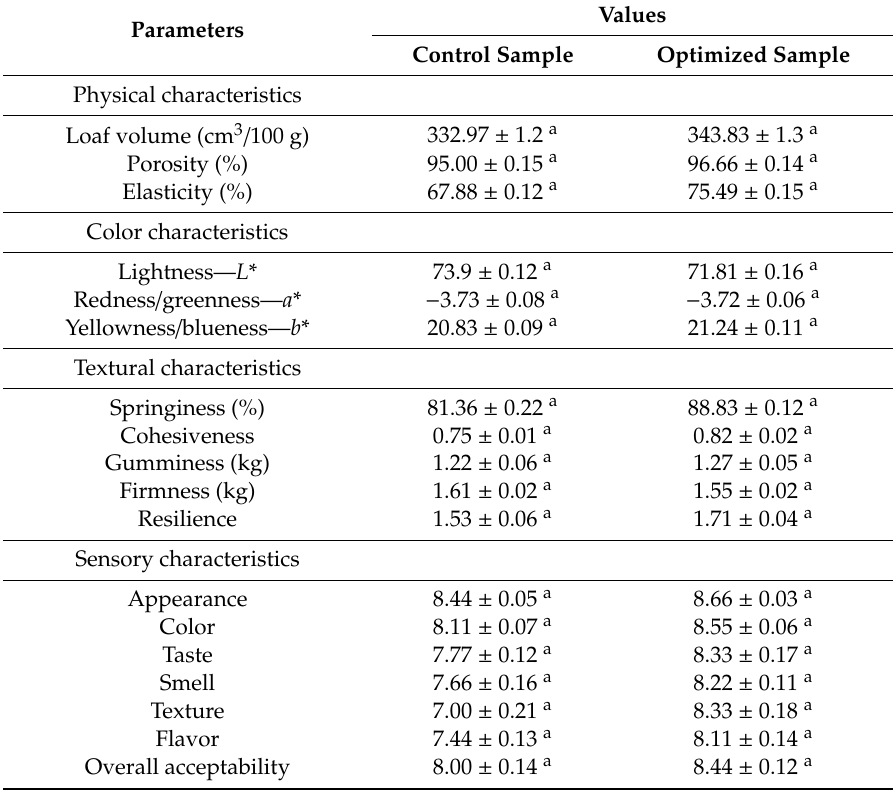
Table 7. The characterization of bread quality characteristics for the samples with 1.5% NaCl